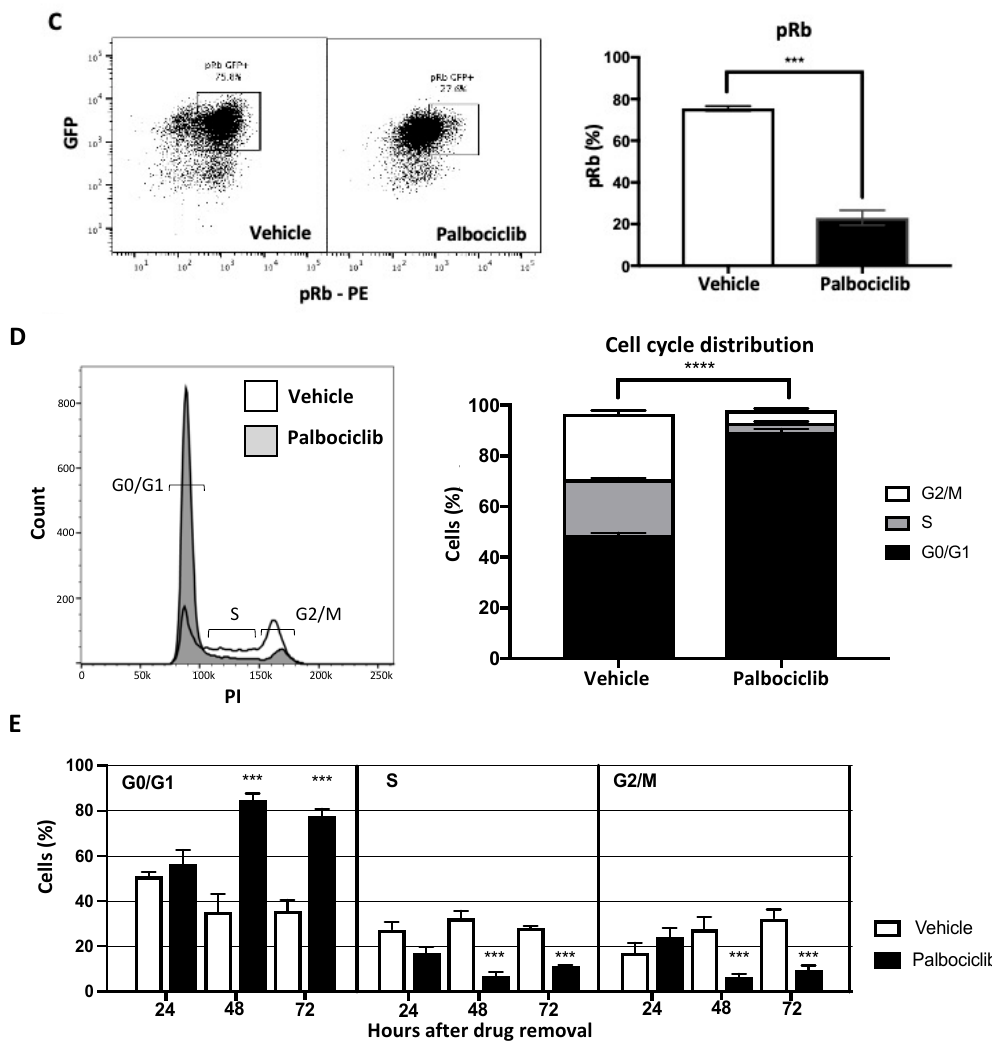
Figure 1. Palbociclib induces cell cycle arrest by inhibiting the phosphorylation of Rb in TNBC cell line. ( A ) Triple negative MDA-MB-231Luc2+GFP+ human breast cancer cells were treated with in- creasing concentrations (1 nM–1 mM) of palbociclib for 72 h after which an MTT proliferation assay was conducted. ( B ) Cells were treated with palbociclib at IC 50 (0.85 µM) or vehicle (sodium lactate) for 72 h and harvested for downstream analyses. Cell lysates were prepared for Western blot for the detection of pRb and total Rb protein. The original Western blot can be found at supplementary Figure S6. ( C ) Flow cytometry analysis of pRb protein (mean ± SEM compared to vehicle ( n = 3, *** p < 0.005; t -test). ( D , E ) Cells were treated with 0.85 µM dose palbociclib or vehicle for 72 h and cell